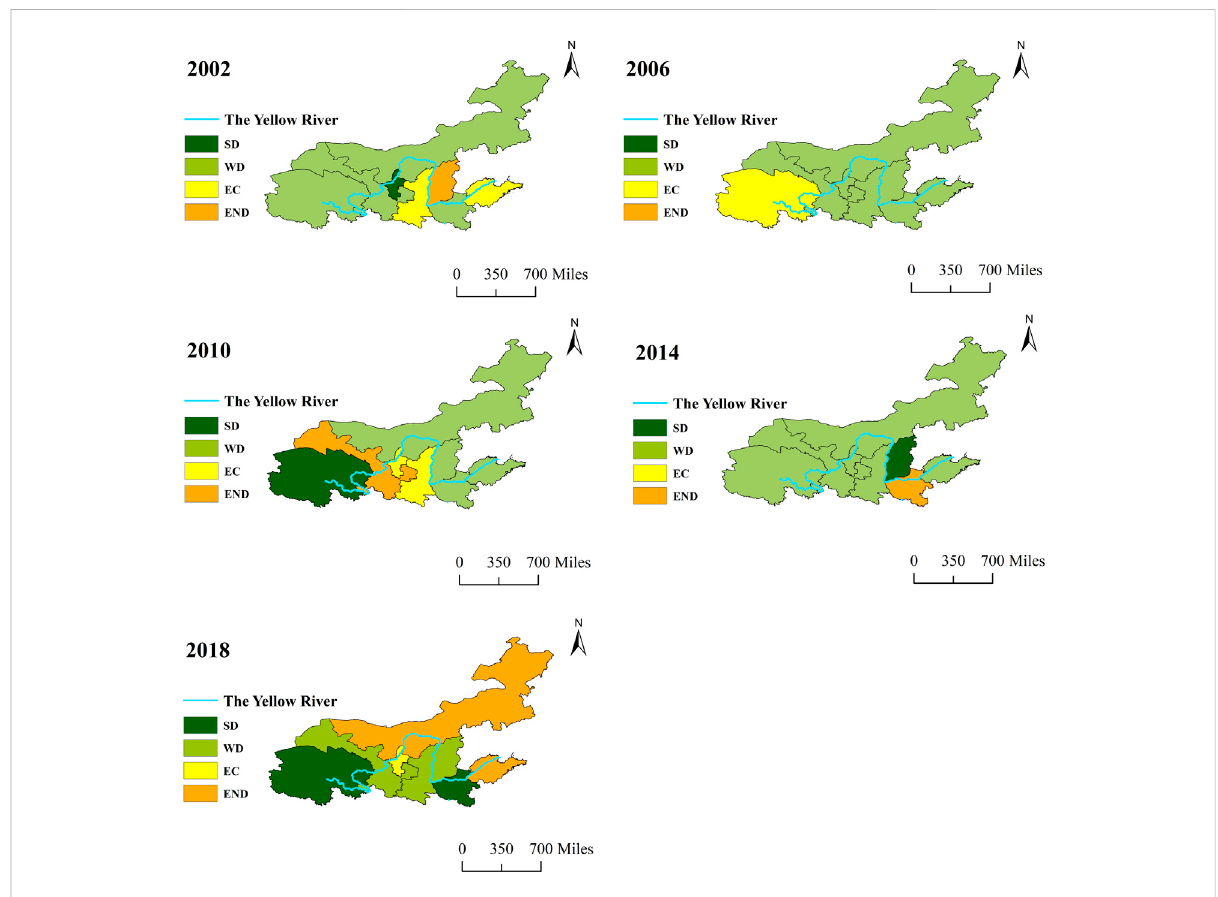
FIGURE 6 Decoupling of carbon emissions and economic growth in the